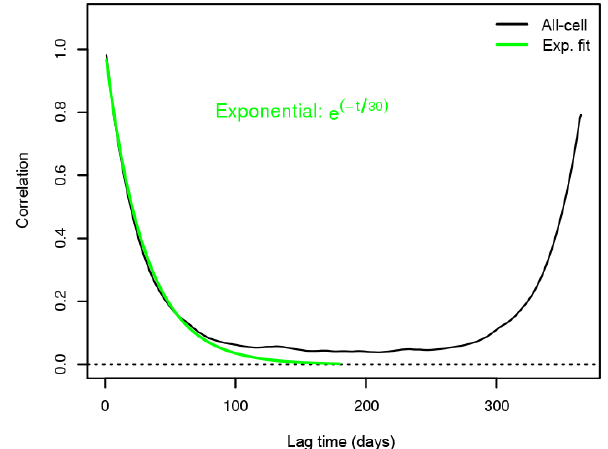
Figure A1. Autocorrelation function for a characteristic frequency of the exponential filter. The autocorrelation is calculated simulta- neously for all the domain grid cells. The numerical realization of the autocorrelation does not decay to zero because of the flux sea-